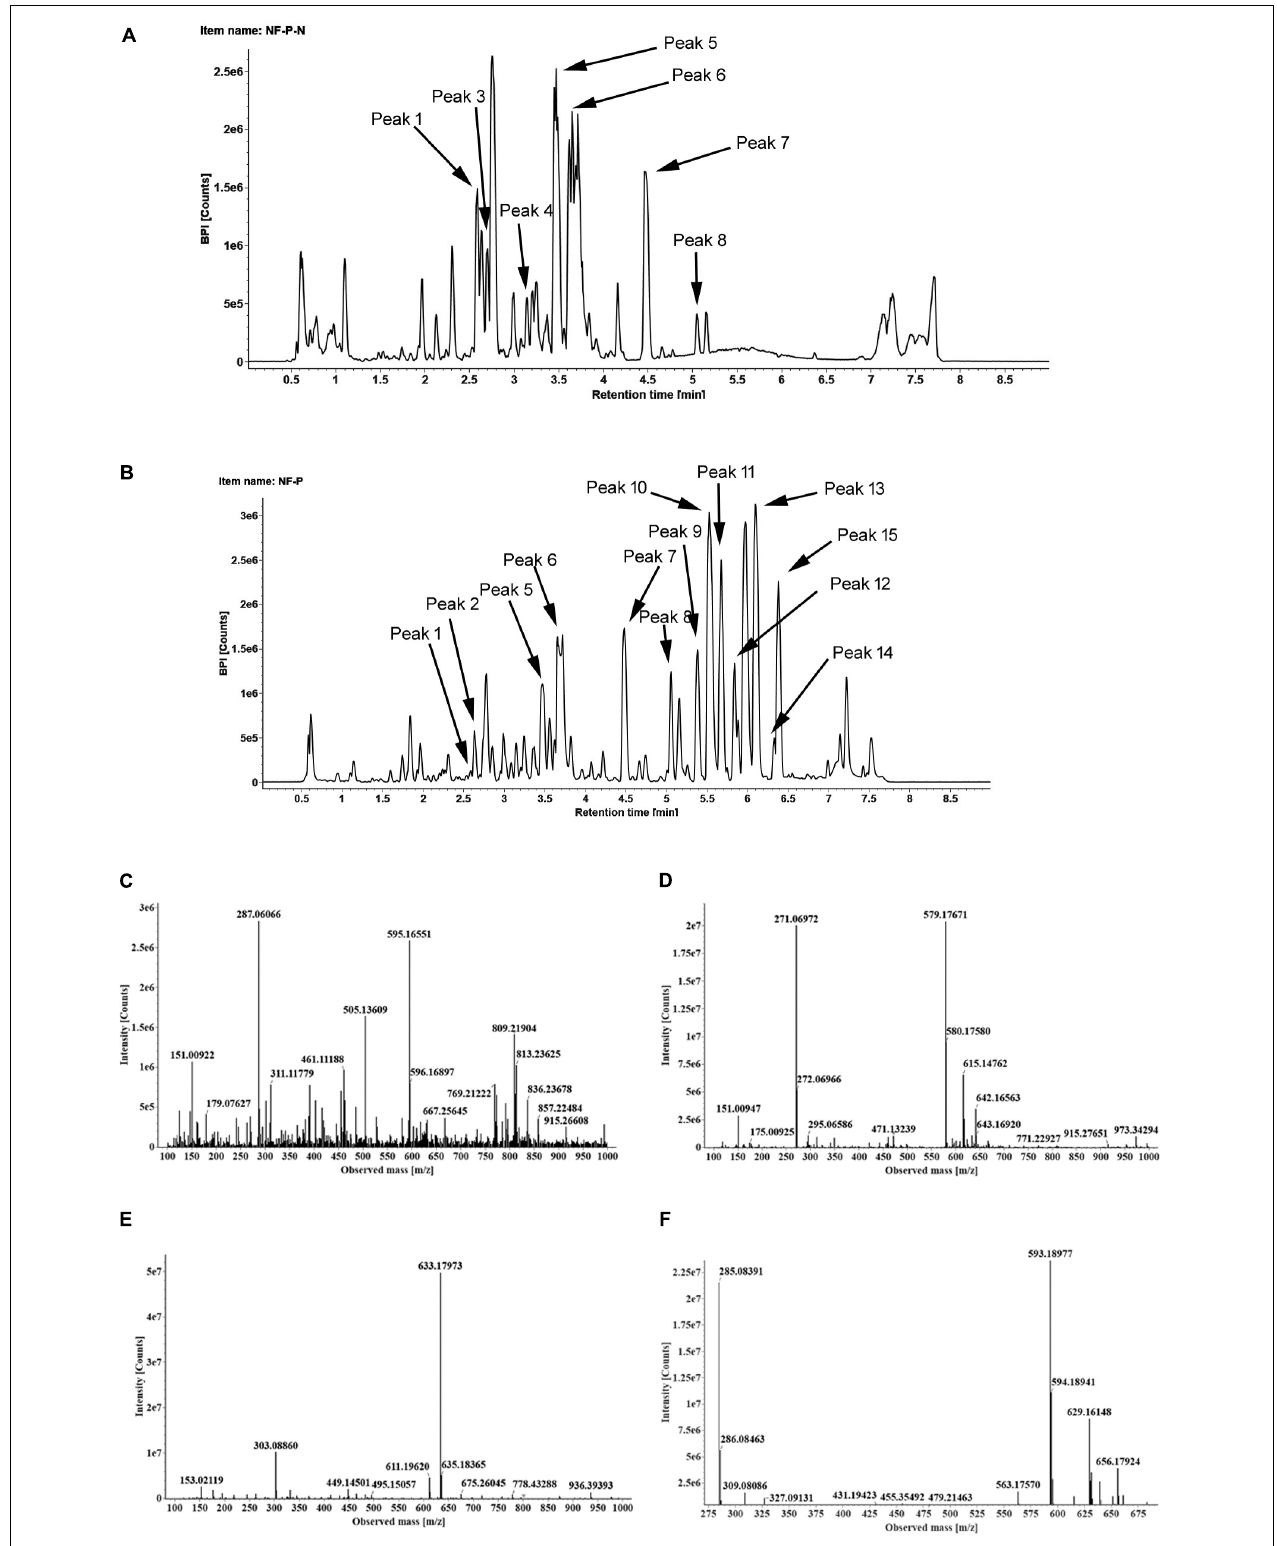
FIGURE 2 | The BPI chromatograms corresponding to negative (A) and positive signals (B) of sweet orange peels at 180 DAB; The MS 2 spectra of four O -glycosylated flavonoids, including eriocitrin (C) , narirutin (D) , hesperidin (E) , didymin (F) .